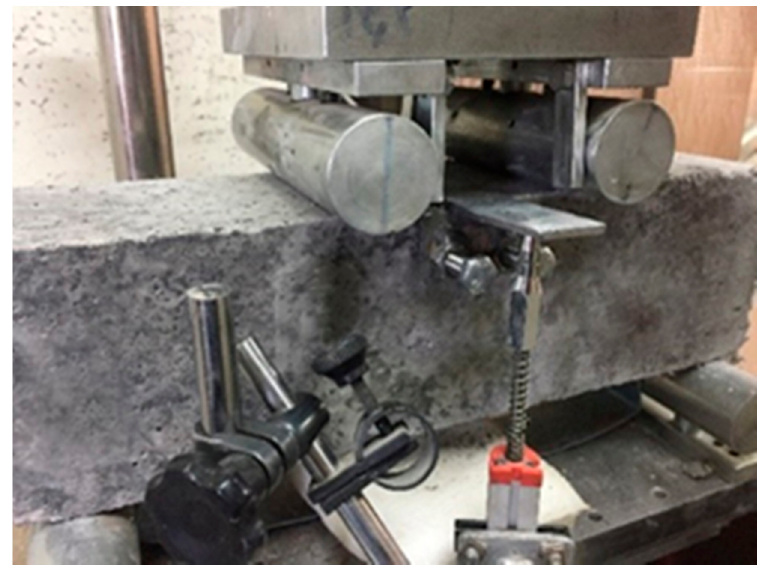
Figure 2. How to adjust the device and sample to test the flexural